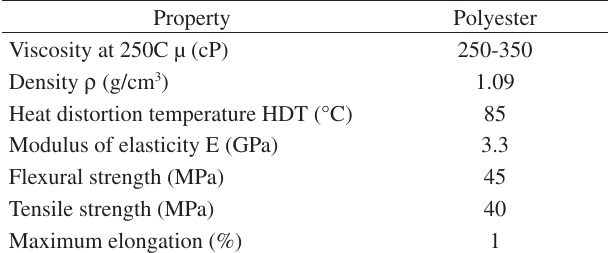
Table 1. Properties of unsaturated polyester resin recycled from PET.